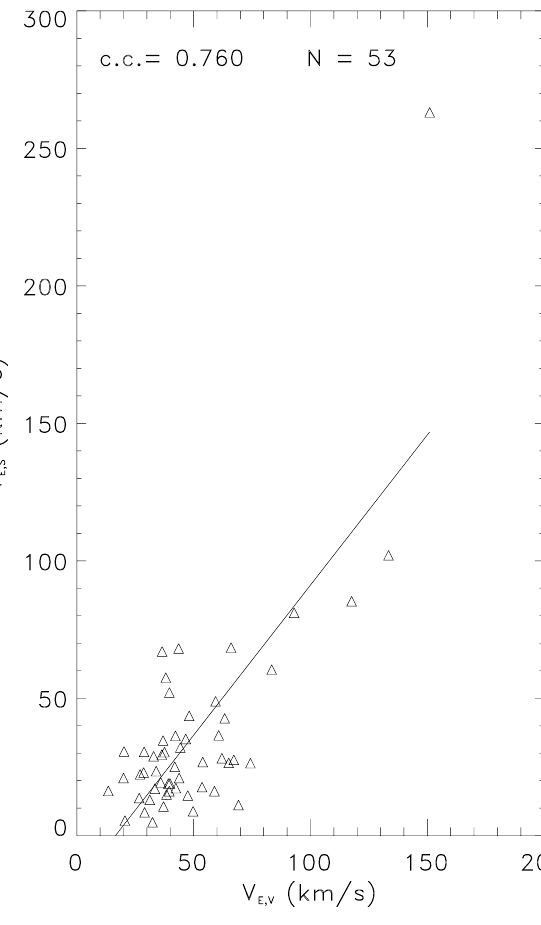
Fig. 4. A scatter diagram of V E,S vs. V E,V showing a linear cor- relation coefficient (c.c.) of 0.76. (Note that there is one value of V E,V of 263km/s that occurs off-scale and therefore is not shown. This value was included in the least-squares fit and in the calcula- tion of c.c., however.)